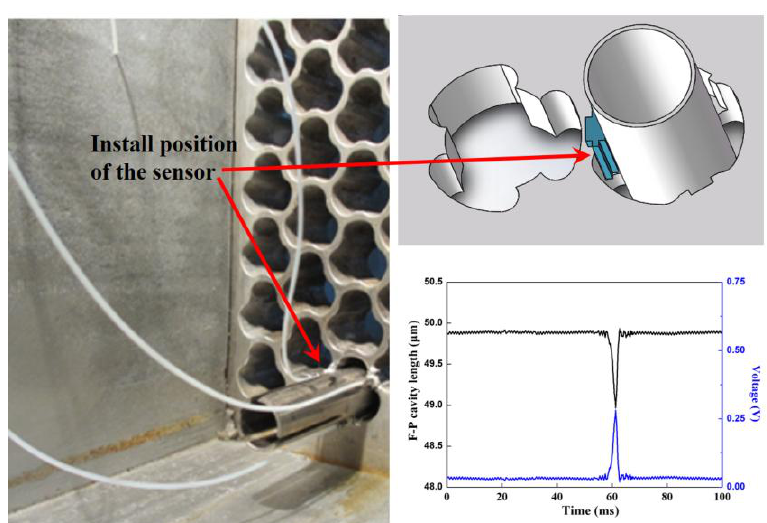
Figure 10. Installed sensors in 1:1 steam generator test loop and the F-P cavity length and the CCD output voltage of one test point.